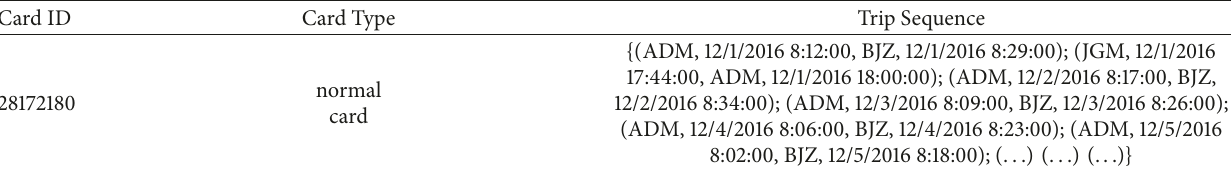
Table 4: An example of the trip sequences for a cardholder after data conversion.